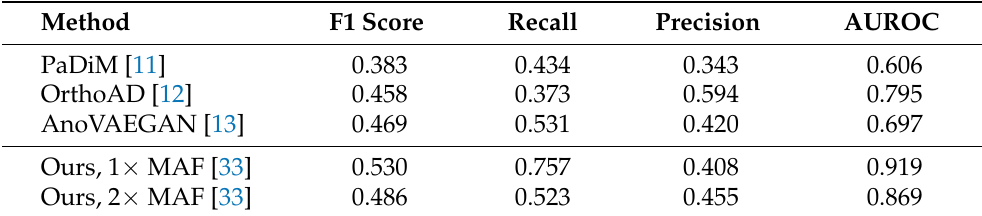
Table 1. Results on the Semmacape dataset. All the models have been trained using the same set of 1000 training images.